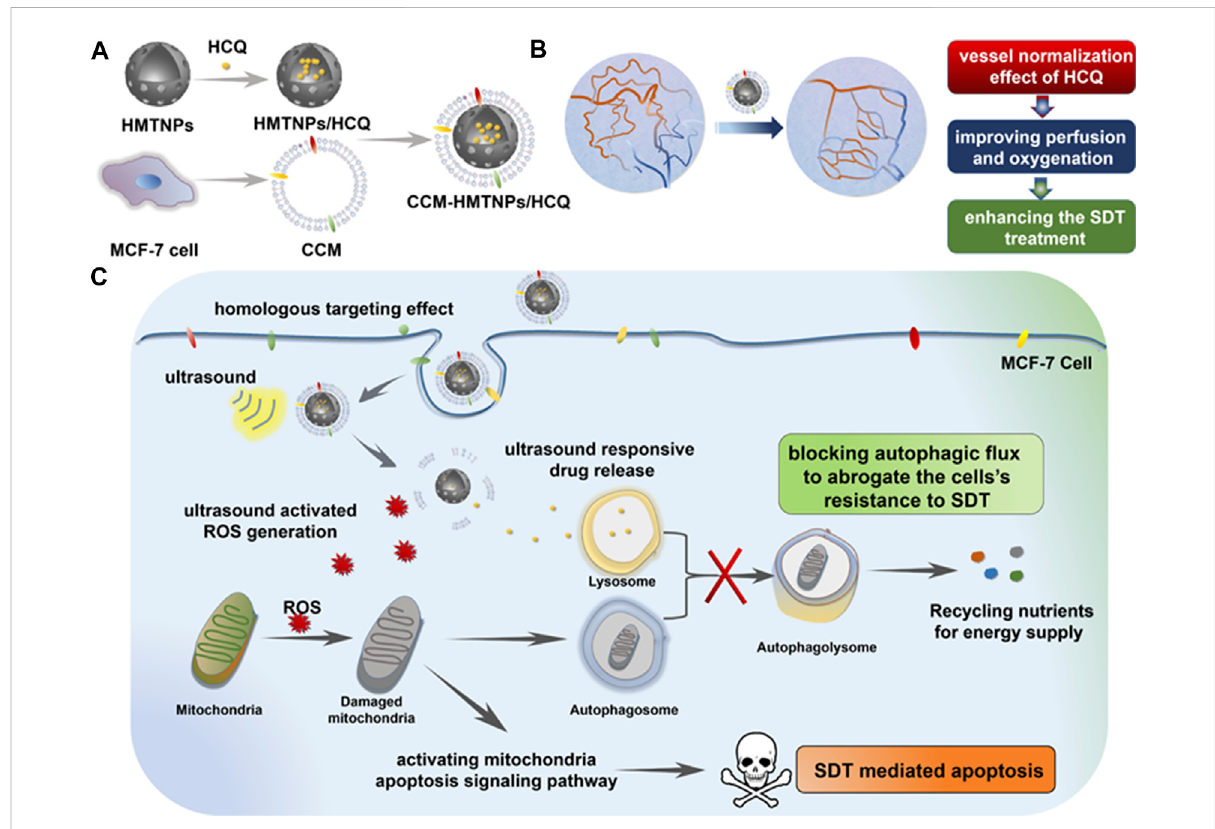
FIGURE 5 Schematic of the Cancer Cell Membrane Biomimetic Nanoplatform. (A) formulation of CCM-HMTNPs/HCQ, (B) vessel normalization effect of HCQ for enhancing the oxygen-dependent SDT treatment, and (C) schematic mechanism of CCM-HMTNPs/HCQ for enhanced SDT on breast cancer via autophagy regulation strategy. Copyright 2019, ACS Applied Materials &